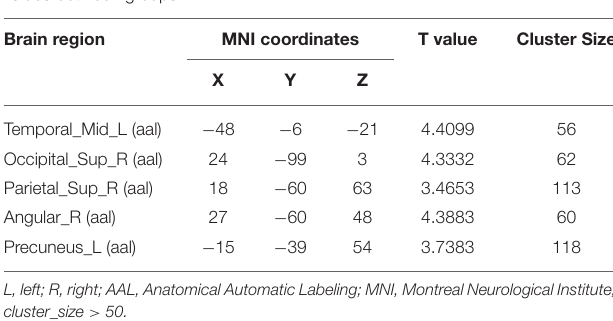
TABLE 2 | Brain areas with significantly different regional homogeneity (ReHo) values between groups.